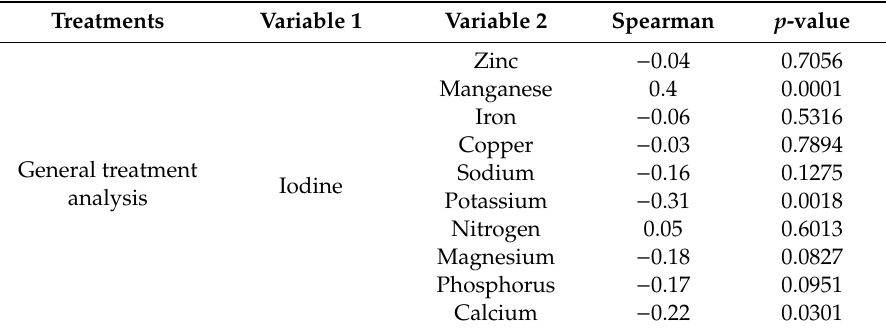
Table 4. Correlation analysis of iodine and minerals.